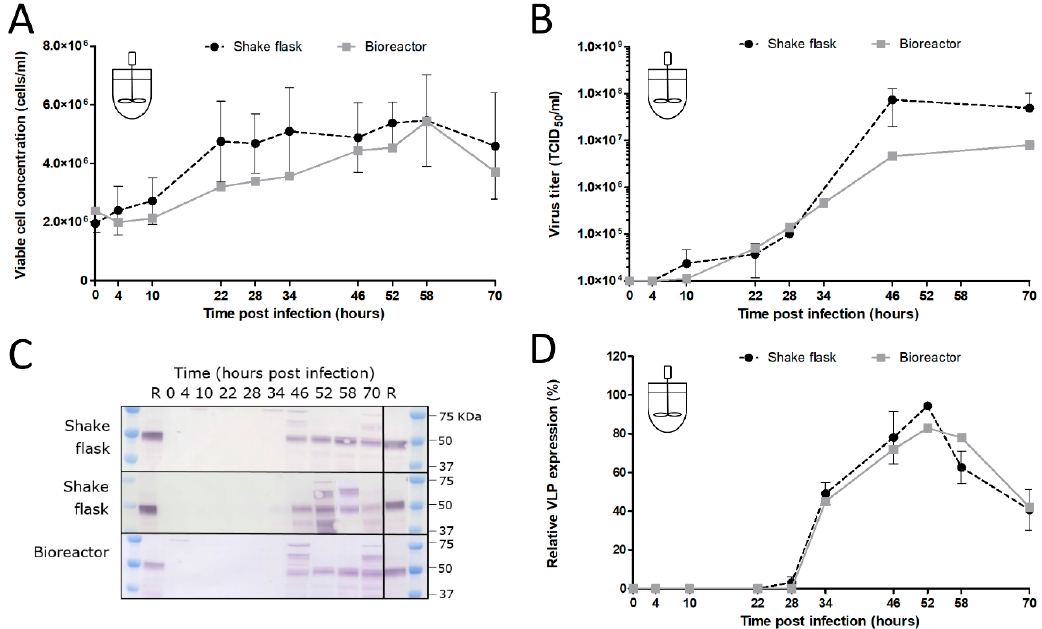
Figure 9. CHIKV VLP production in an insect cell bioreactor ( A ) Cell growth after BACe56-CHIKV infection of Sf9 cells in bioreactor compared to shake flask. Infections were performed at MOI 0.01 TCID 50 / cell and CCI 2 × 10 6 cells / mL. ( B ) Baculovirus titers upon BACe56-CHIKV infection cells in bioreactor compared to shake flask. Viral titers were determined by end point dilution assay and are expressed as tissue culture infective dose 50% per ml (TCID50/mL). ( C ) CHIKV VLP expression determined by Western blot detection with anti-E2 polyclonal antiserum. R; reference VLPs ( D ) Relative CHIKV VLP expression levels in bioreactor compared to shake flask, determined by Western blot detection with anti-E2 polyclonal antiserum.